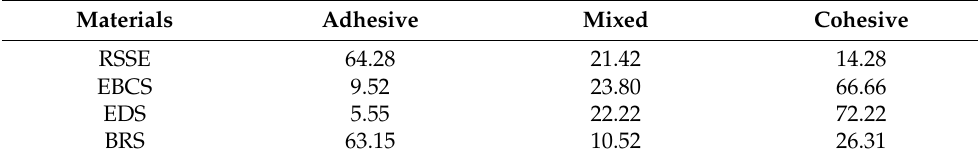
Table 5. Distribution of failure mode during dislodgement for tested sealers (as a